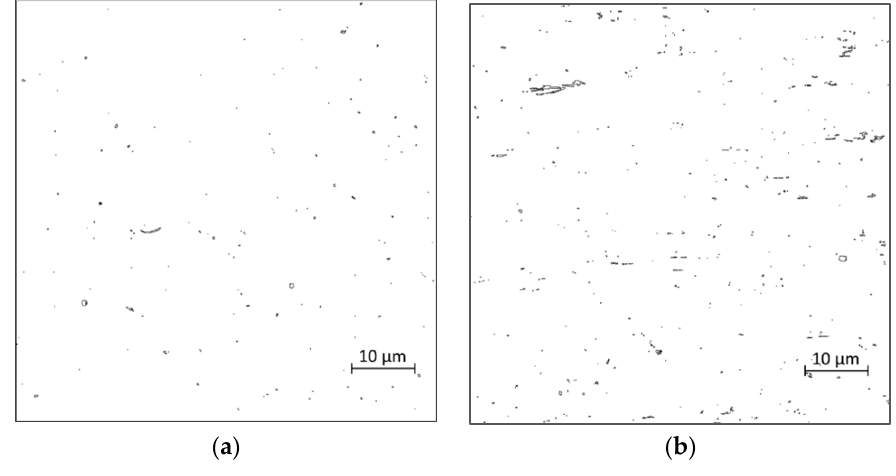
Figure 7. Pores of specimens: ( a ) N5, ( b ) N7.